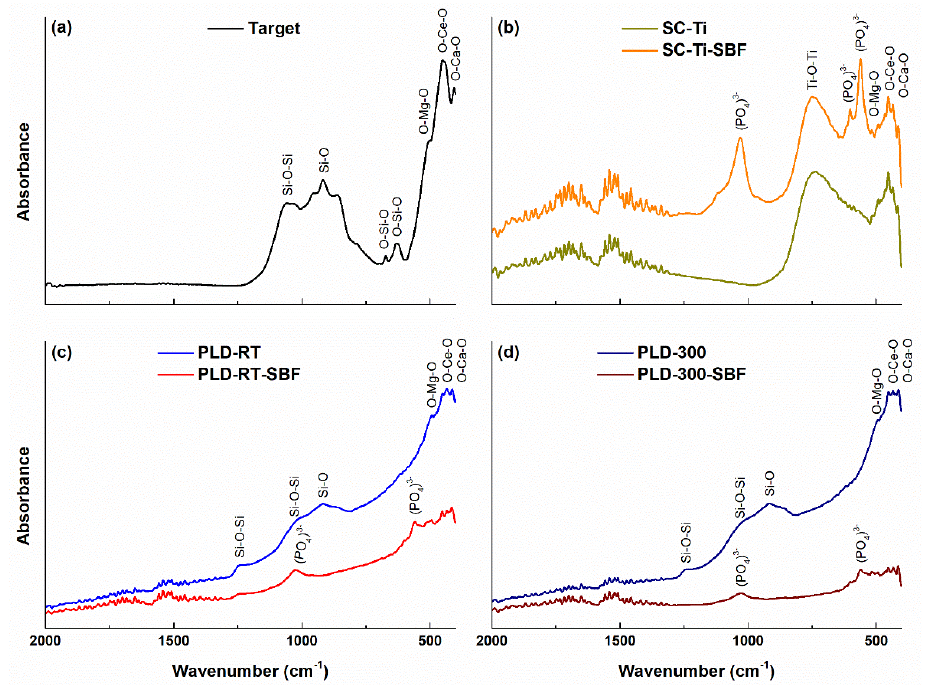
Figure 5. FTIR spectra of: ( a ) target, ( b ) SC-Ti thin film, ( c ) PLD-RT thin film and ( d ) PLD-300 thin film, both before and after SBF immersion for 28 days.